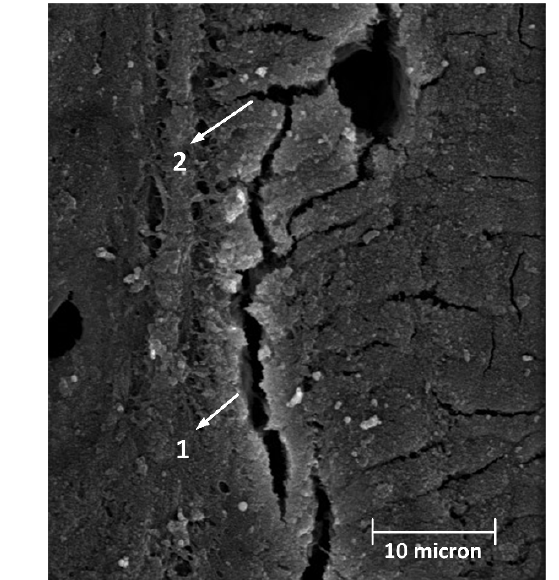
Figure 8: The SEM image of the interface between the layered lamel- lae and the interstitial bone of cortical bone after loading. The white arrow 1 indicates that cracks parallel to the layered lamellae, tended to interconnect with each other and form a large crack; the white arrow 2 indicates a tiny crack captured by the